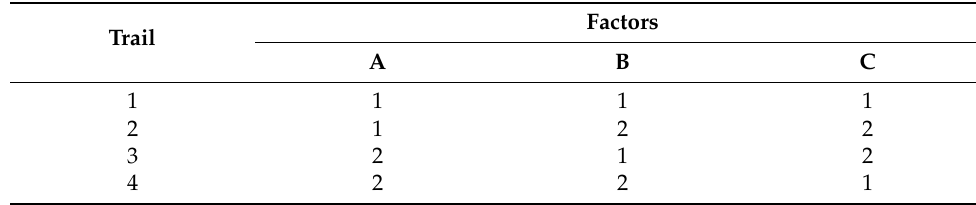
Table 3. L-4 Orthogonal Array.